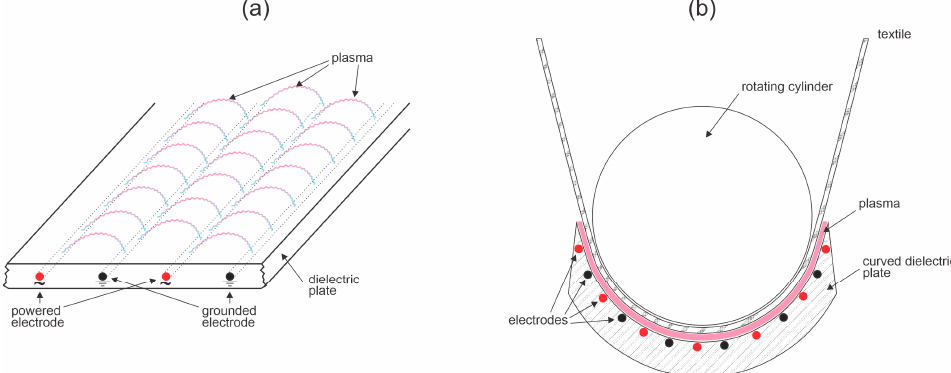
Figure 6. Schematic of the surface discharges sustained in the DBD mode ( a ) and a feasible solution to assure a constant distance between the textile and the dielectric plate for uniform treatment of textile surfaces ( b textile surfaces ( b ).